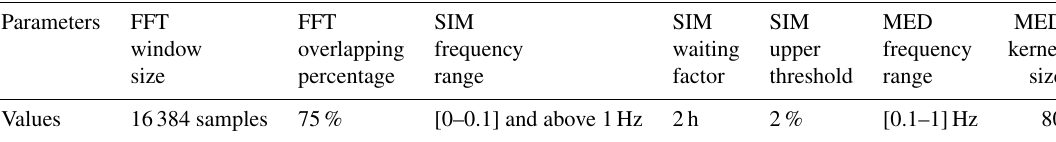
Table 1. Parameter values used in our study. Parameters FFT FFT SIM SIM SIM MED MED window overlapping frequency waiting upper frequency kernel size percentage range factor threshold range size